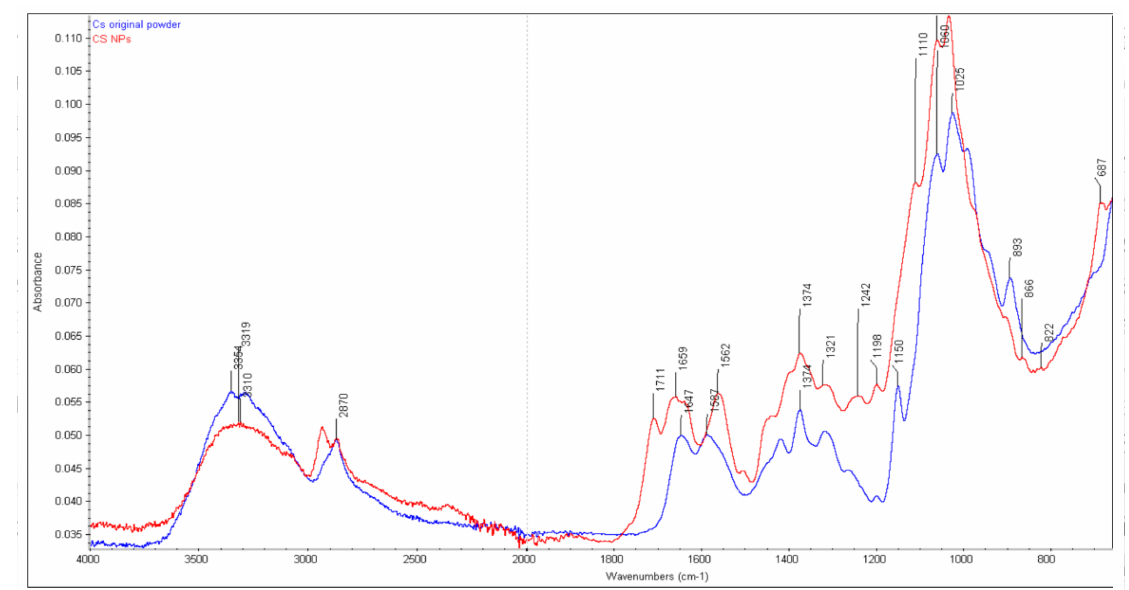
Figure 1. FTIR spectra of CS original powder and CS NP before incubating in 0.2 mg/mL lysozyme solution.